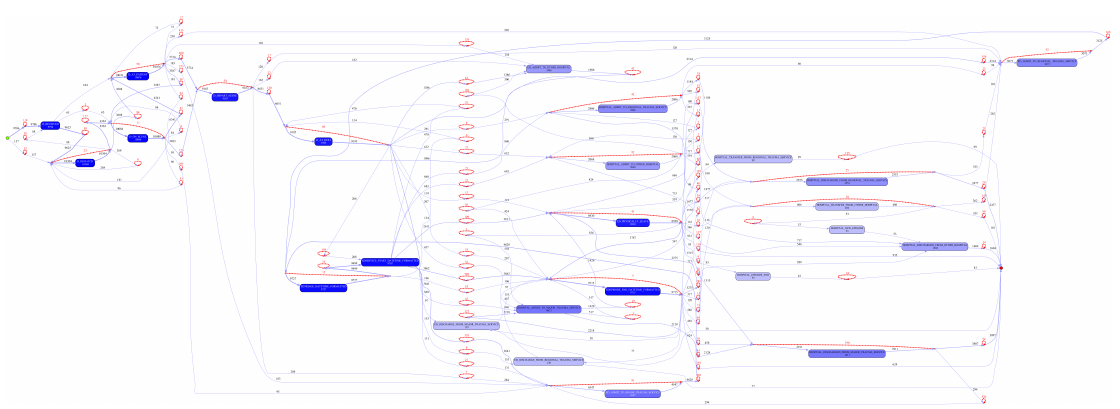
Figure 8. Automatically discovered process model of Cohort 3—80% path abstraction.